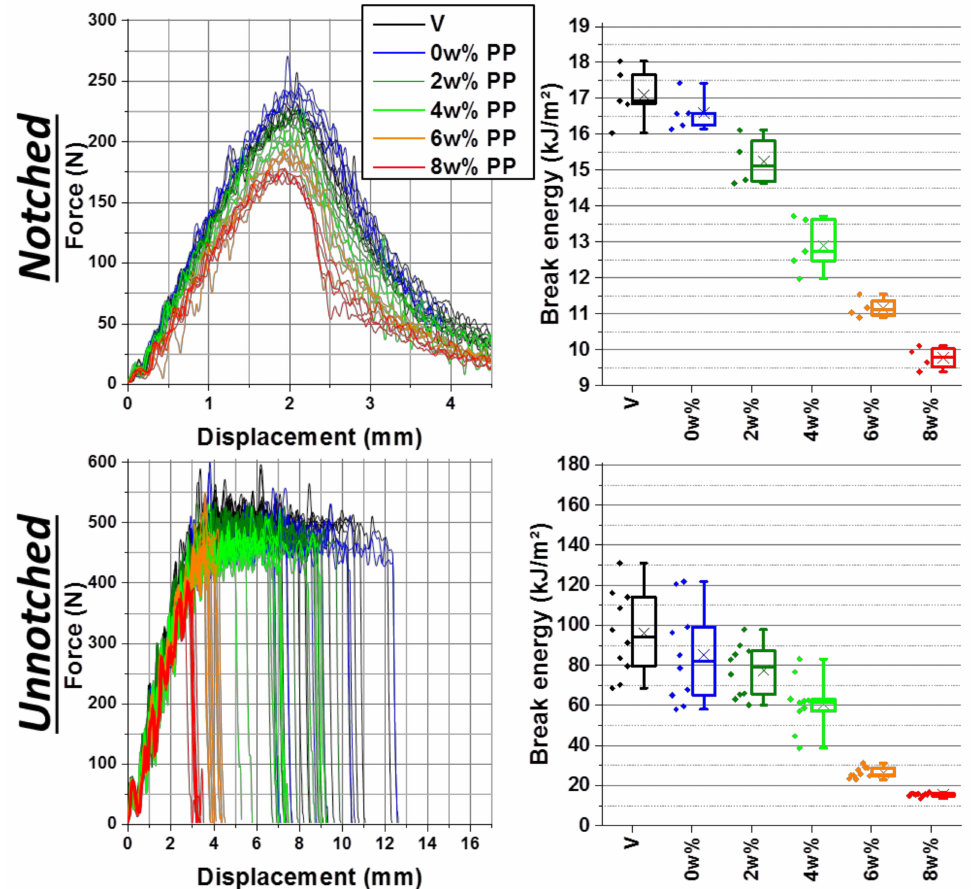
Figure 2. Force–displacement curves ( left ) and break energies boxplots ( right ) of notched ( top ) and unnotched ( bottom ) Charpy impact tests on ABS contaminated at increasing rates of PP —“V” for directly injected ABS, “0 wt%” went through